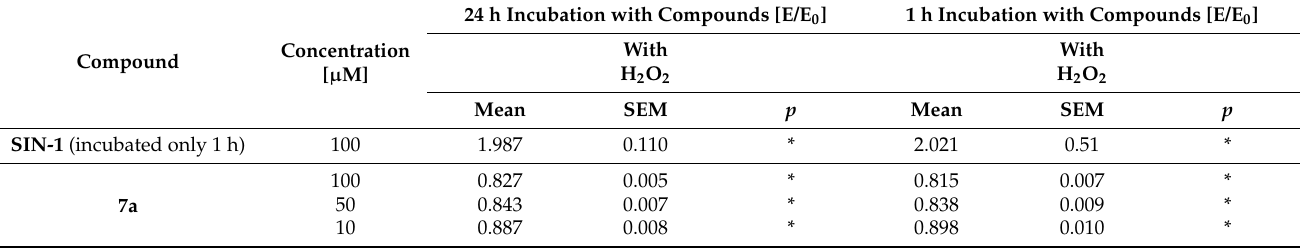
Table 7. Lipid peroxidation after incubation with tested compounds [mean (SD); n = 3]; the results were compared to the control and expressed as E/E0 ratios; statistical significance calculated with post hoc test compared to the control (* p < 0,05; E0—cultures without tested